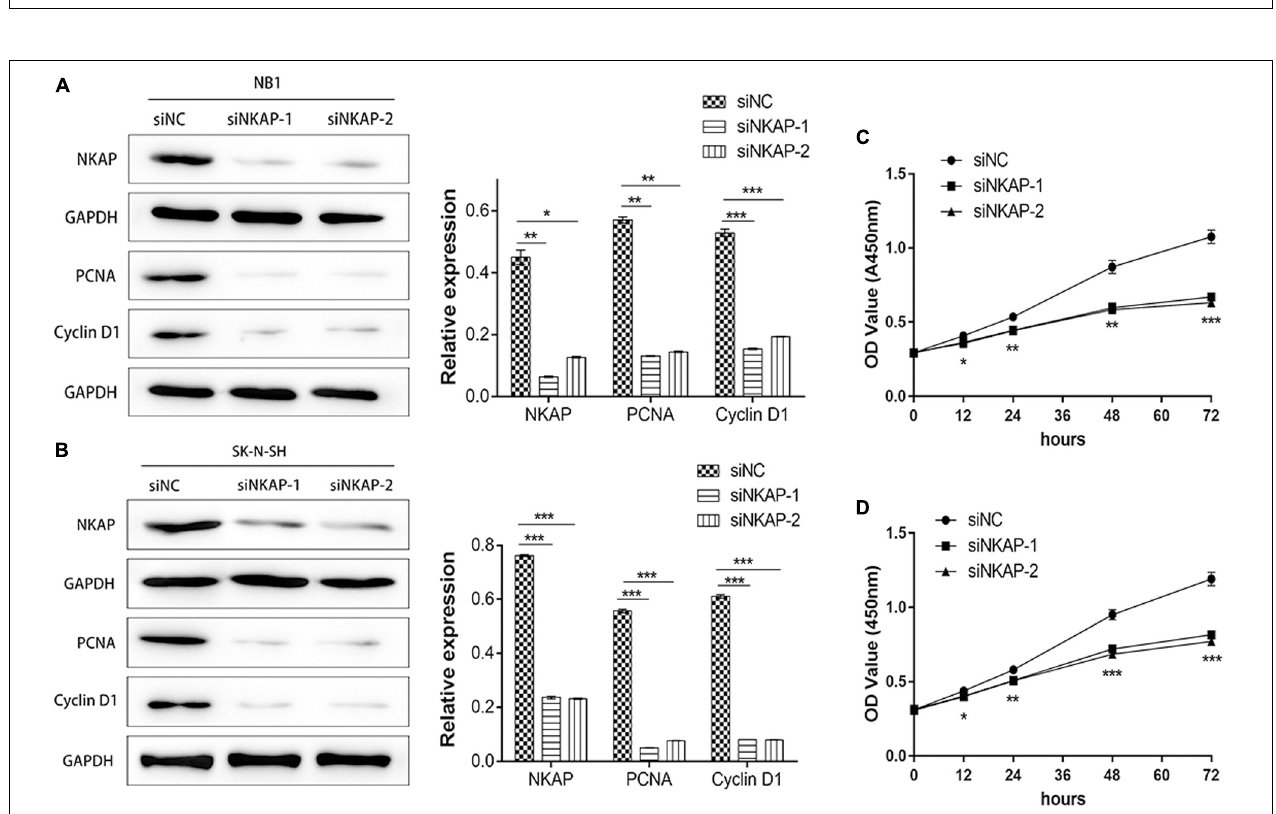
FIGURE 3 | Knockdown of NKAP attenuated proliferation of neuroblastoma cells in vitro and in vivo . Western blot showed that siNKAP inhibited proliferation of NB1 cell (A) and SK-N-SH cell (B) compared with siNC. Cell proliferation of NB1 (C) and SK-N-SH (D) detected by CCK8 assay. *** P < 0.001, ** P < 0.01, * P < 0.05.